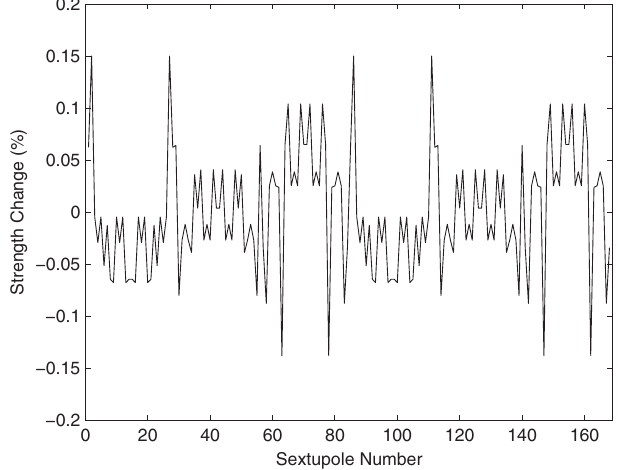
FIG. 8. Measured beam current during the sextupole optimi- zation. See also Fig. 9 for further information.